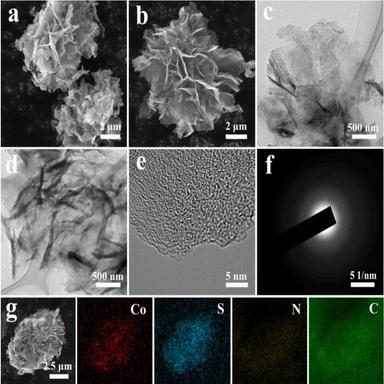
Morphology and microstructure of the Co9S8/CHS: (a–b) SEM images; (c–d) TEM images and (e) HRTEM images; (f) SAED patterns; (g) EDX mappings.